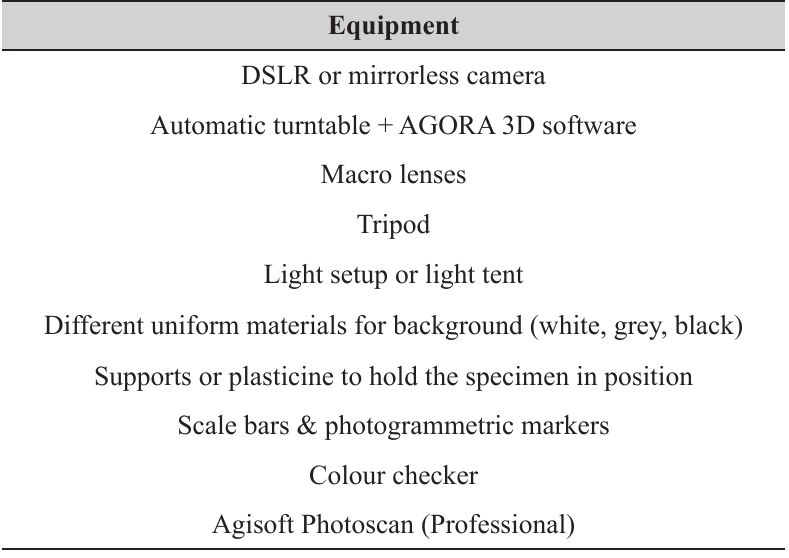
Table 3.1. Equipment list to perform photogrammetry of large specimens